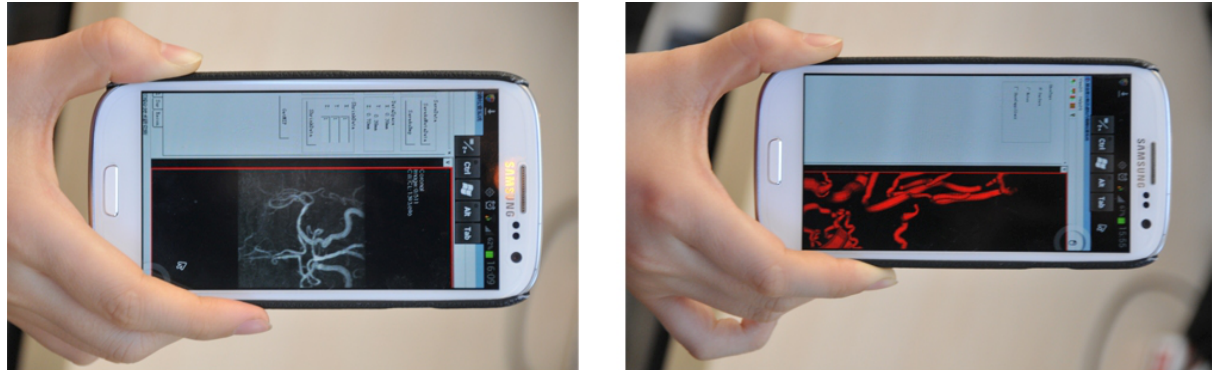
Figure 14. The interface of the mobile phone client. Left: MIP projection data displayed at mobile phone Client; right: Segmentation results at mobile phone